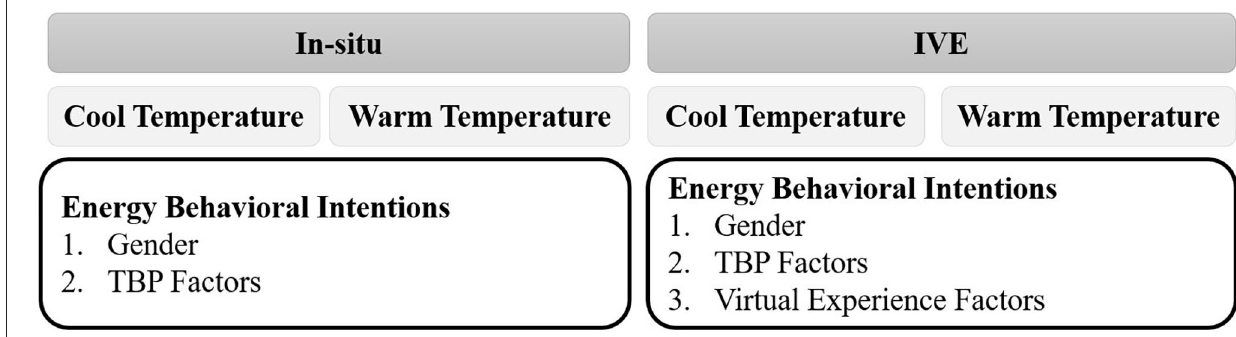
FIGURE 4 | Data segmentation and factor assignment for analyzing behavioral intentions.